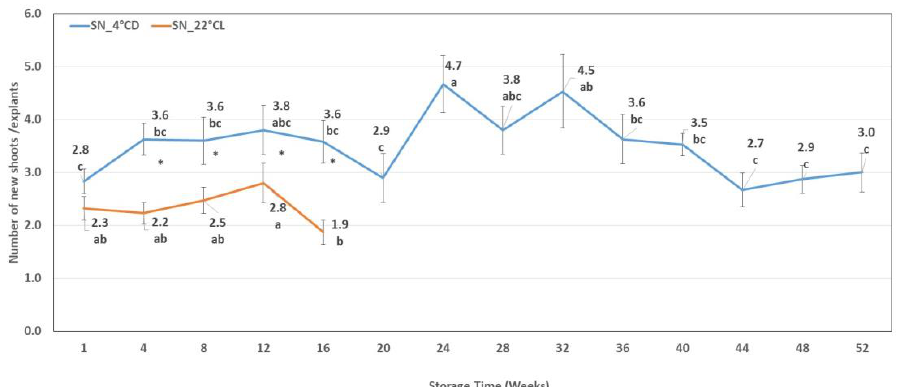
Figure 8. Shoot number (SN) of new shoots developed on subcultured explants from cold storage (SN_4 °CD) and in the growth chamber (SN_22 °CL). Line graphs present mean values ± SE of SN of new shoots developed from subculture. Lower case indicates the significant differences between the SN measured after different storage times. * indicates the significant differences between the SN measured after different storage conditions.